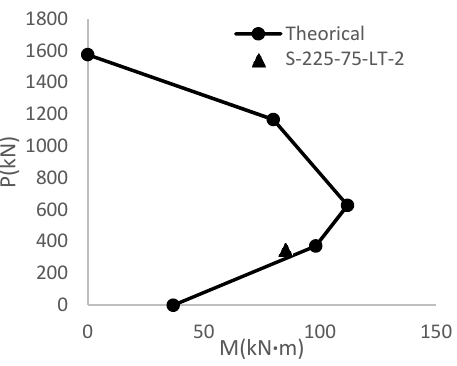
Figure 6. Theoretical interaction curve for the S ‐ 225 ‐ 75 ‐ LT ‐ 2 specimen with the experimental P ‐ M pair.